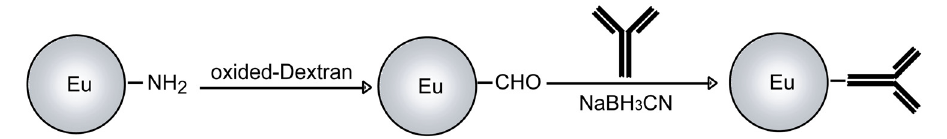
Fig 4. Scheme of labeling of antibody with BC-EDTA/Eu 3+